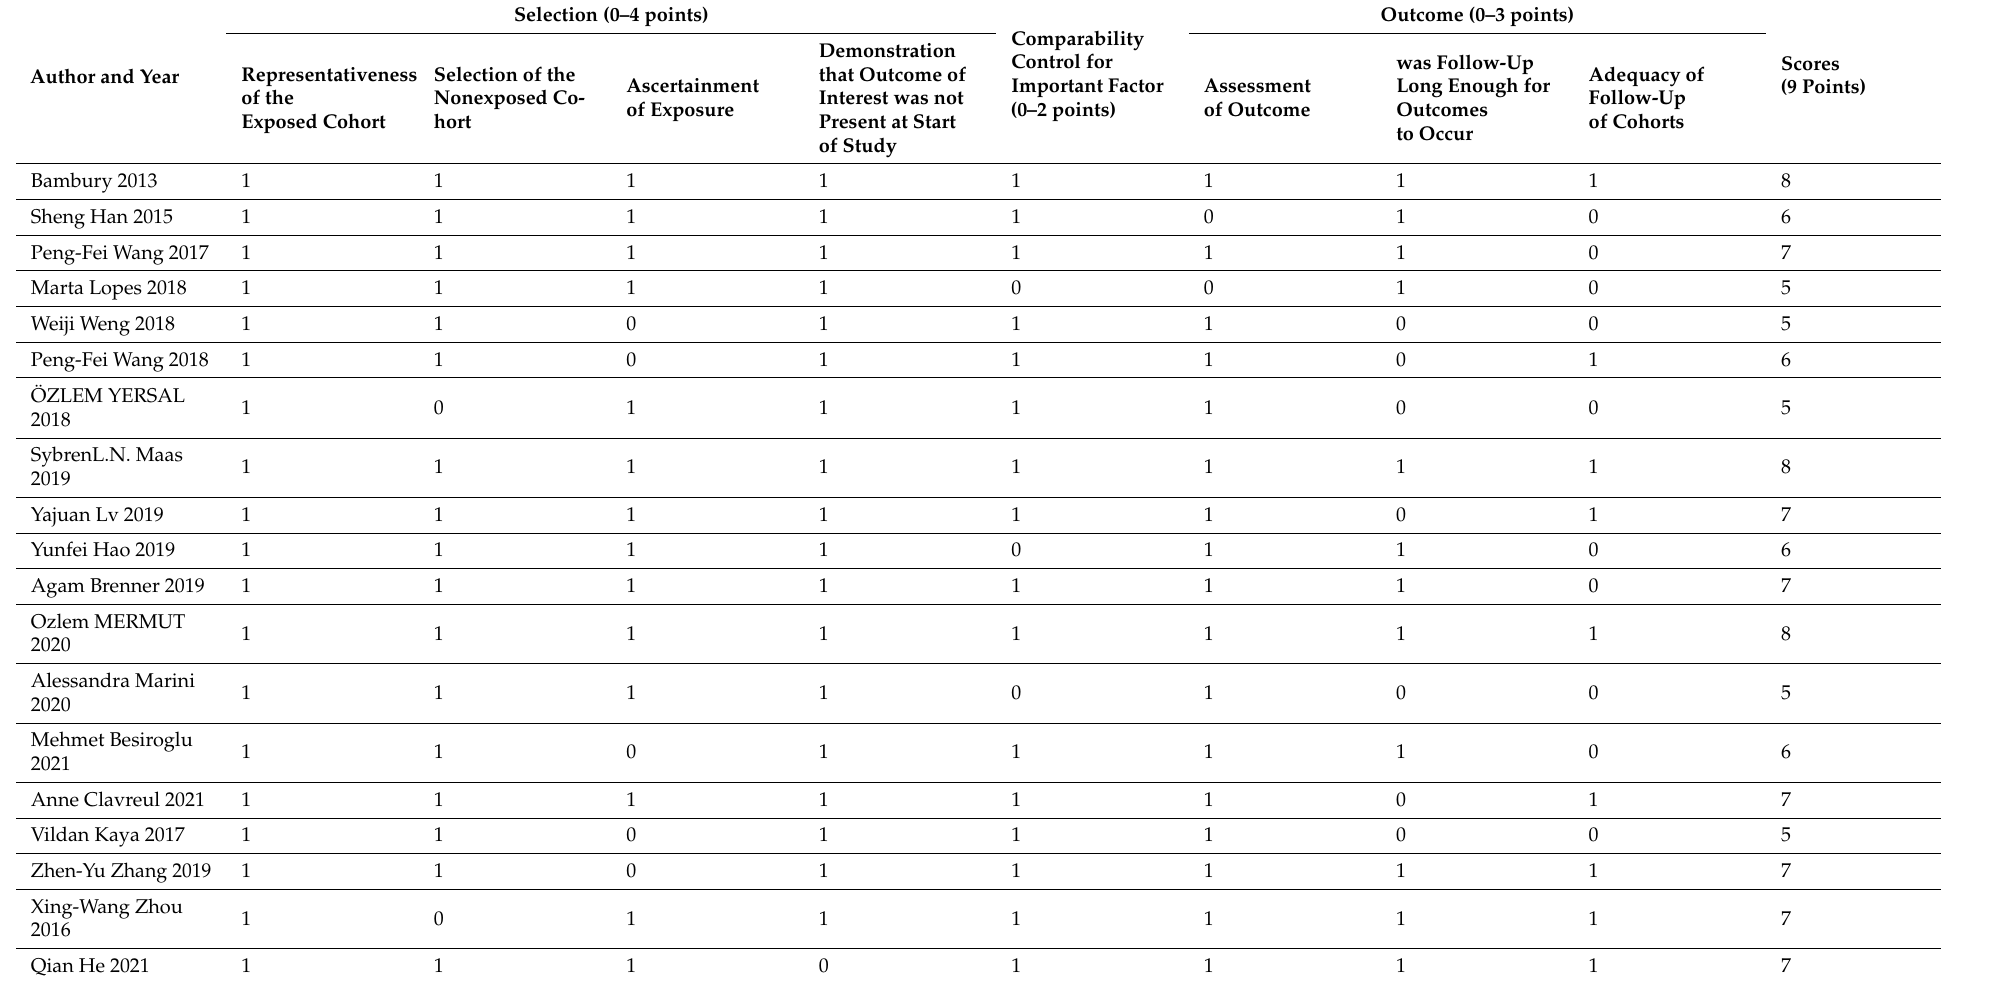
Table 2. Results of quality assessment using the Newcastle-Ottawa Scale for case-control